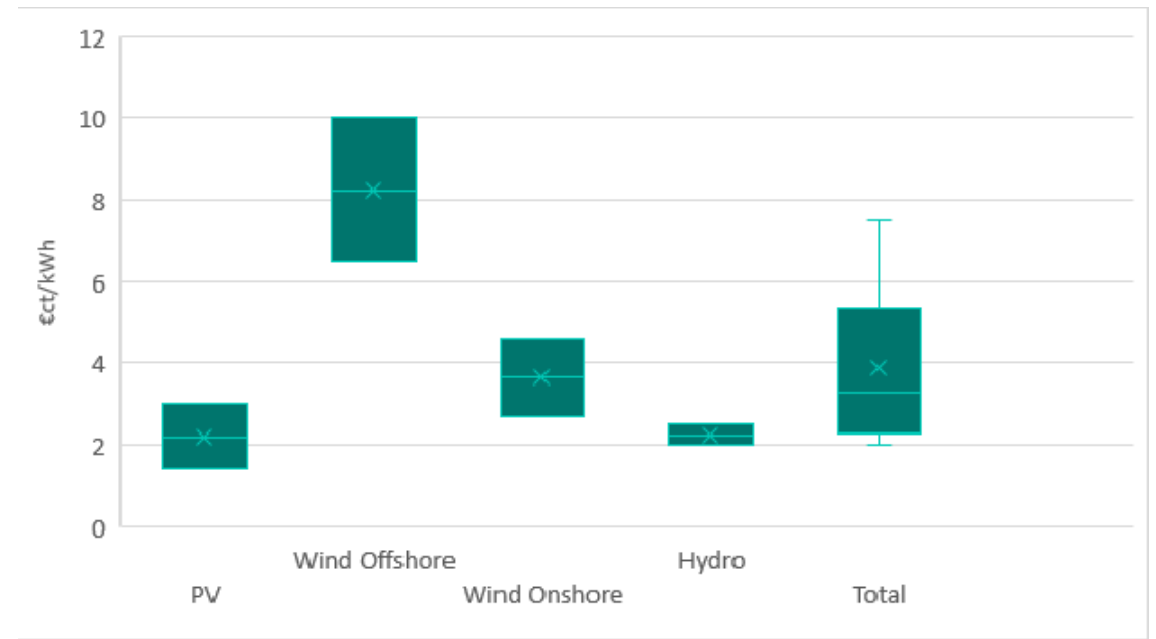
Figure 12. Costs of power generation per technology in 2050 in €cent/kWh.